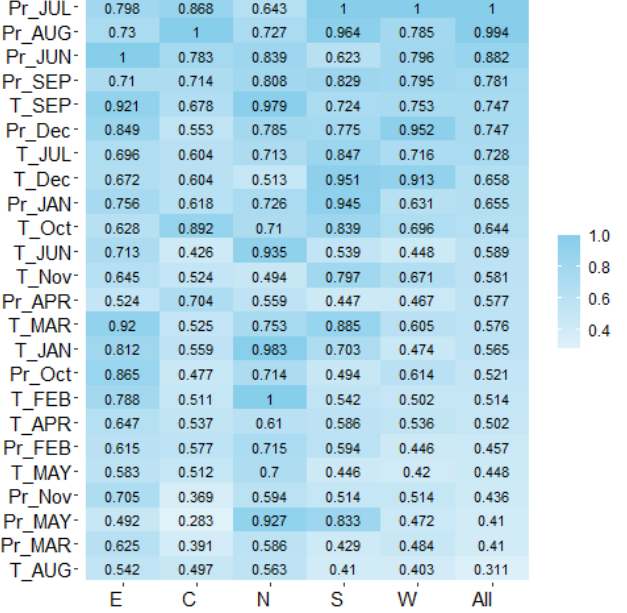
Figure 11. The importance of monthly climatic variables on the ring-width index (RWI) regarding the location of the origin of pine provenances (T indicates monthly temperature and Pr indicates monthly precipitation; all letters in caps indicate months of current year, and lowercase letters indicate months of previous year).